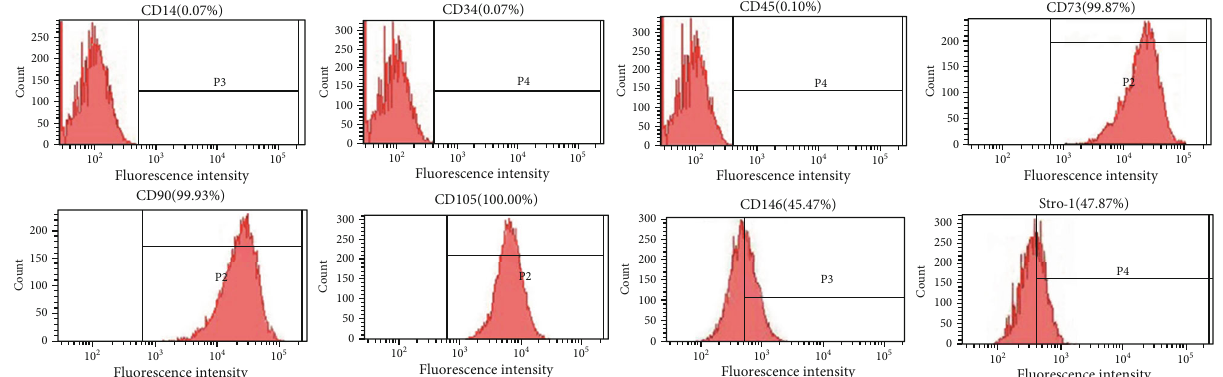
Figure 2: FACS identi fi cation of the surface marker expressions of rGMSCs. CD73, CD90, CD105, CD146, and Stro-1 were highly expressed, while rGMSCs were negative for CD14, CD34, and CD45.